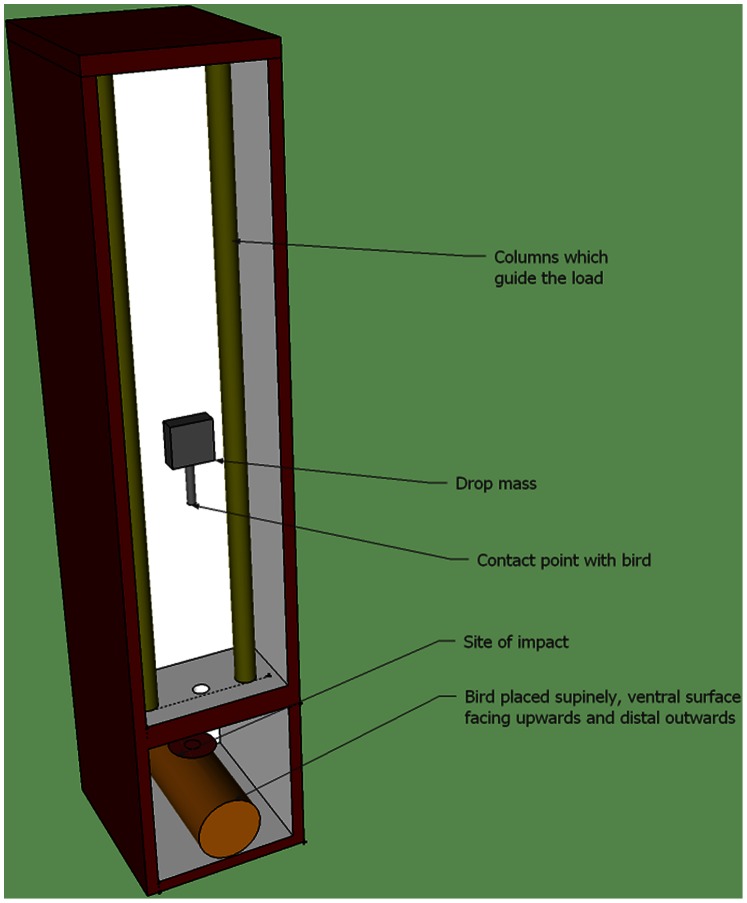
Schematic diagram of the impact device used to deliver loads during impacts.The device consisted of columns placed vertically between which an aluminium block (5×5×2 cm) of a specified mass (3.8 kg) could be dropped from specific heights onto a bird positioned at the base of the device. Runners affixed to the drop mass ensured the load could be delivered with high accuracy and precision to a target with minimum friction during travel. By altering the height from which the drop mass was released, the energy of impact could be changed accordingly. A rod extending from the base of the drop mass contained a force transducer which provided the peak force during impact. Actual contact with the bird was made with a crescent shaped metal flashing attached to the end of the rod.